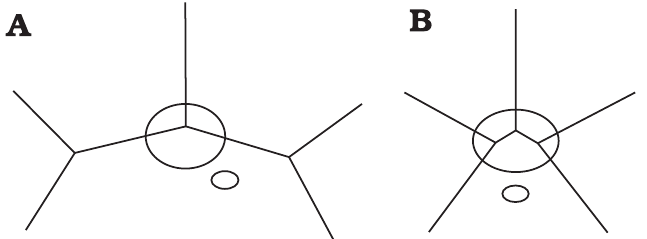
Fig. 1. Orals in early pentaradial echinoderms. A . Plesiomorphic tem- plate expressing the 2-1-2 pattern. B . Near pentameric symmetry, showing potential pentaradiality through shortening initial branches during ontogeny.